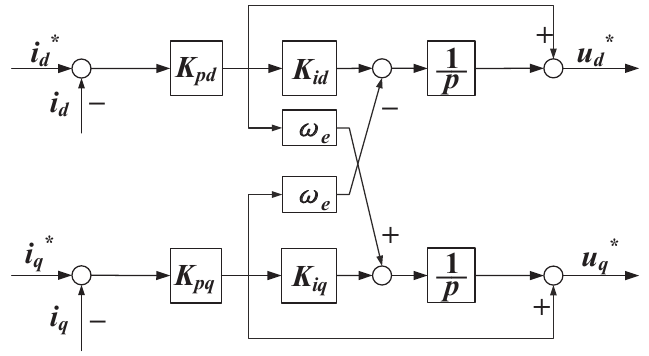
Figure 4. Illustration of the current regulator.